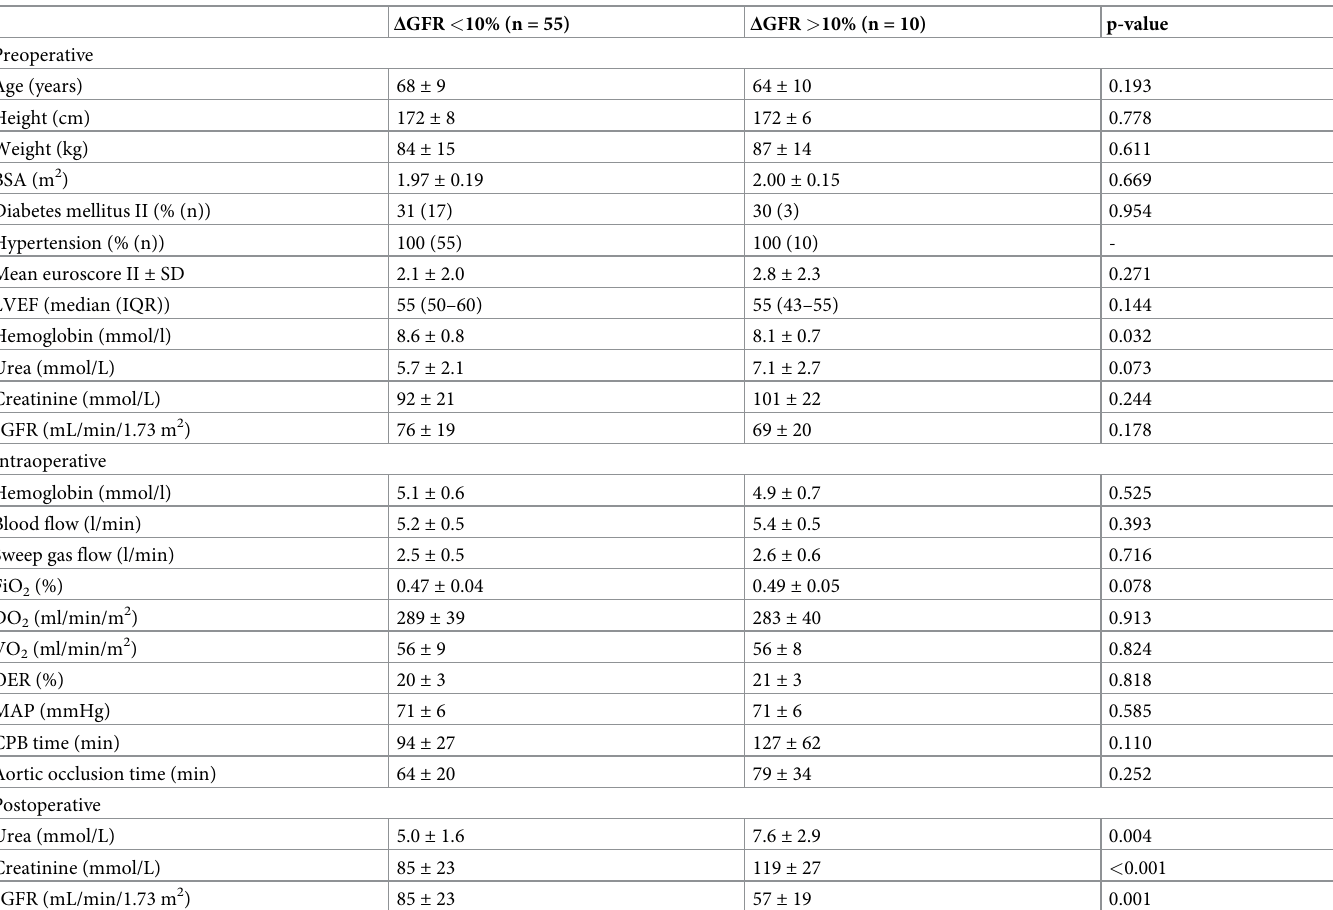
Table 3. Preoperative and intraoperative variables split based on a Δ eGFR of